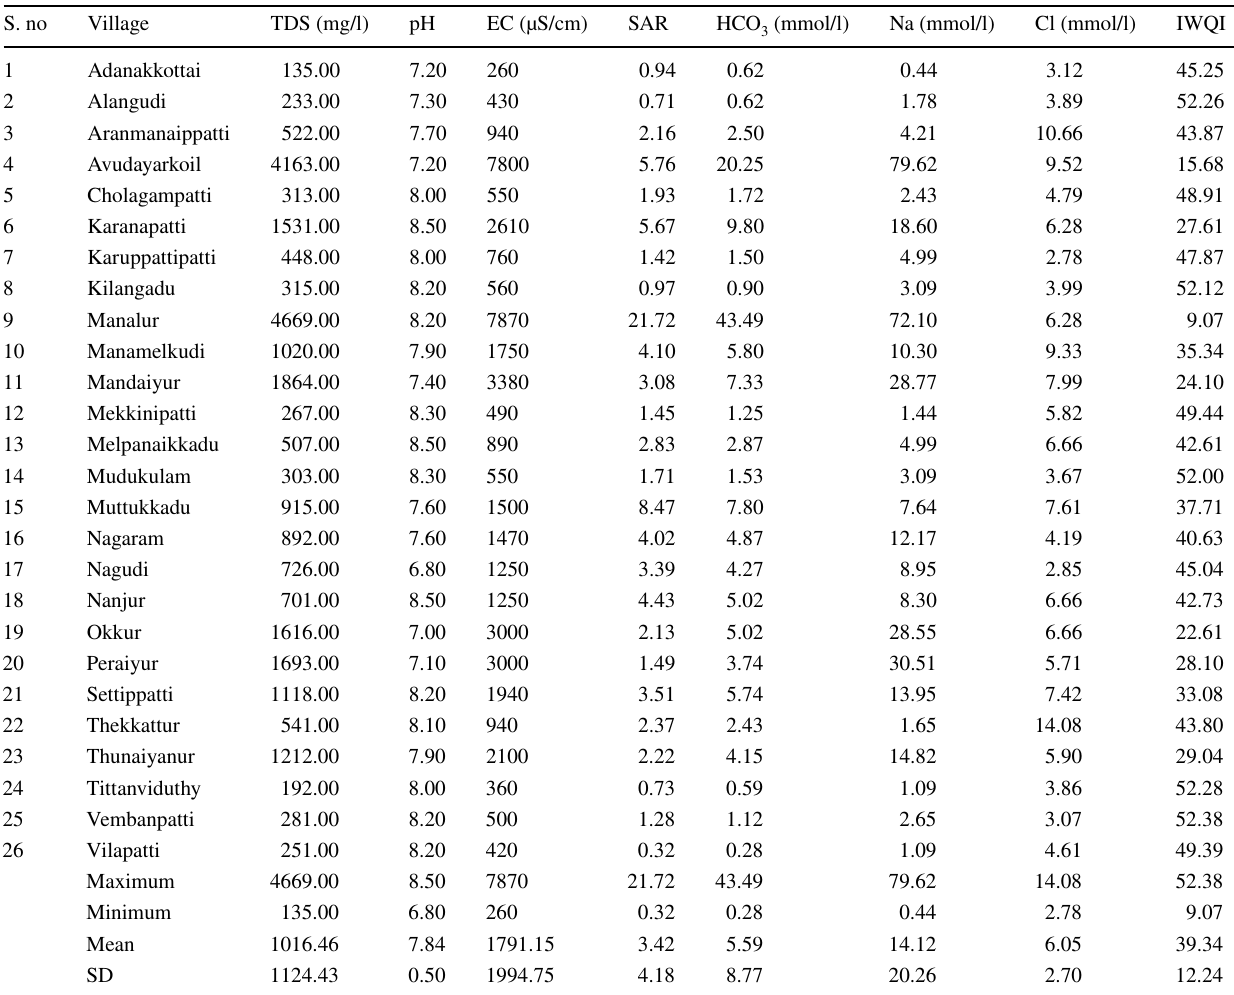
Table 2 Water quality and irrigational water quality index (IWQI) of Pudukkottai district—2015 S. no